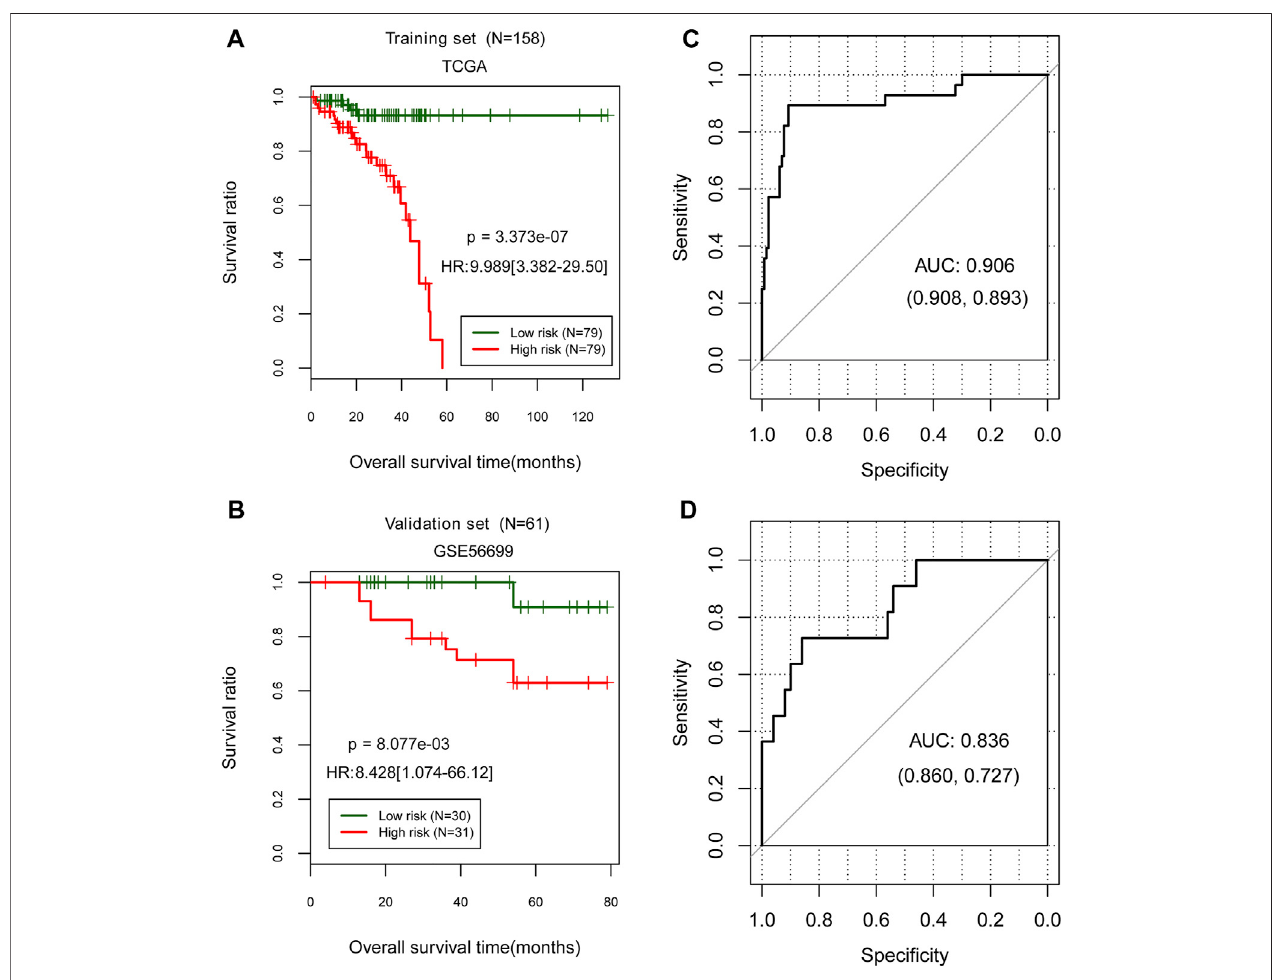
FIGURE 4 | Evaluation of the prognostic risk model in TCGA training data set and GSE56699 validation dataset. (A,C) Kaplan – Meier curve method was used to evaluateaprognosticriskmodelintheTCGAtrainingandGSE56699validationdatasets.TheROCcurveoftheprognosticriskmodelpredictionresults (B,D) .Numbers in parentheses in the fi gure represent the ROC curve ’ s speci fi city and sensitivity.